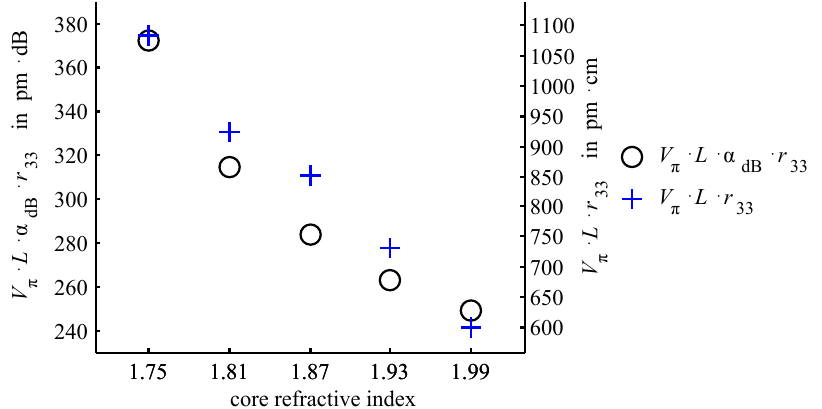
Figure 7. Results of the simulations to determine the optimal core refractive